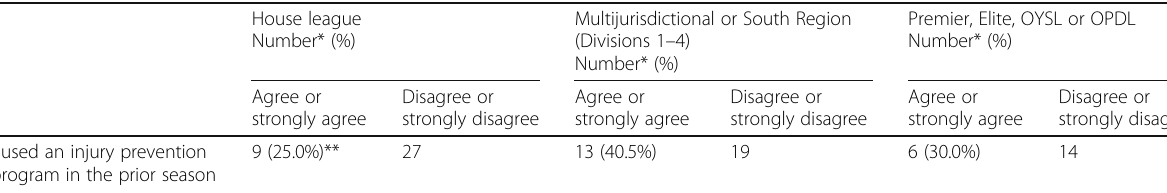
Table 4 Intervention use by level of team